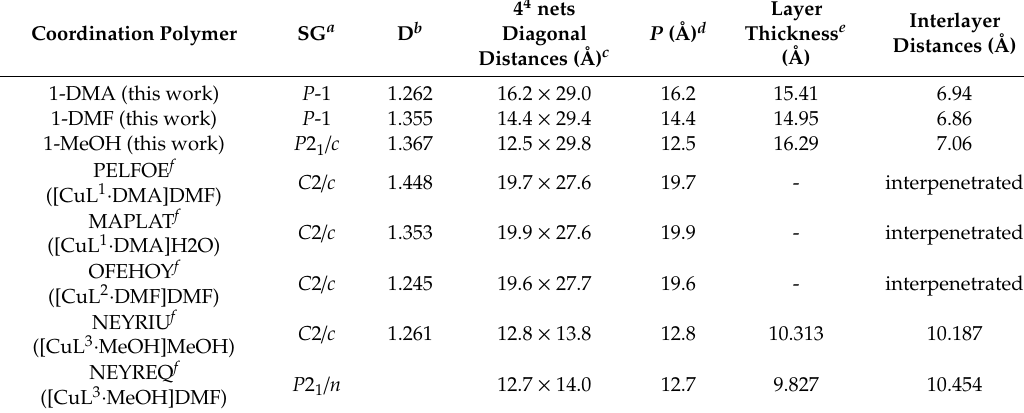
Table 1. Selected crystal parameters for compounds in this work and related 2D